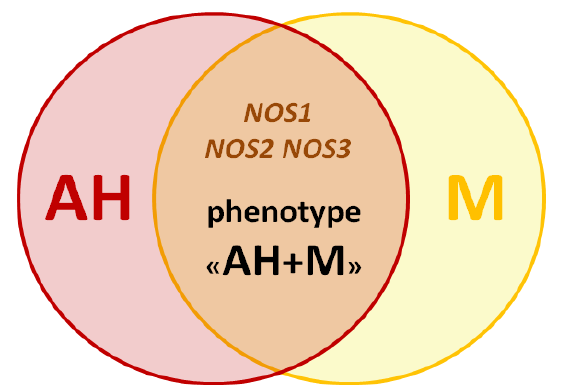
Figure 2. The scheme of the migraine and arterial hypertension phenotype.